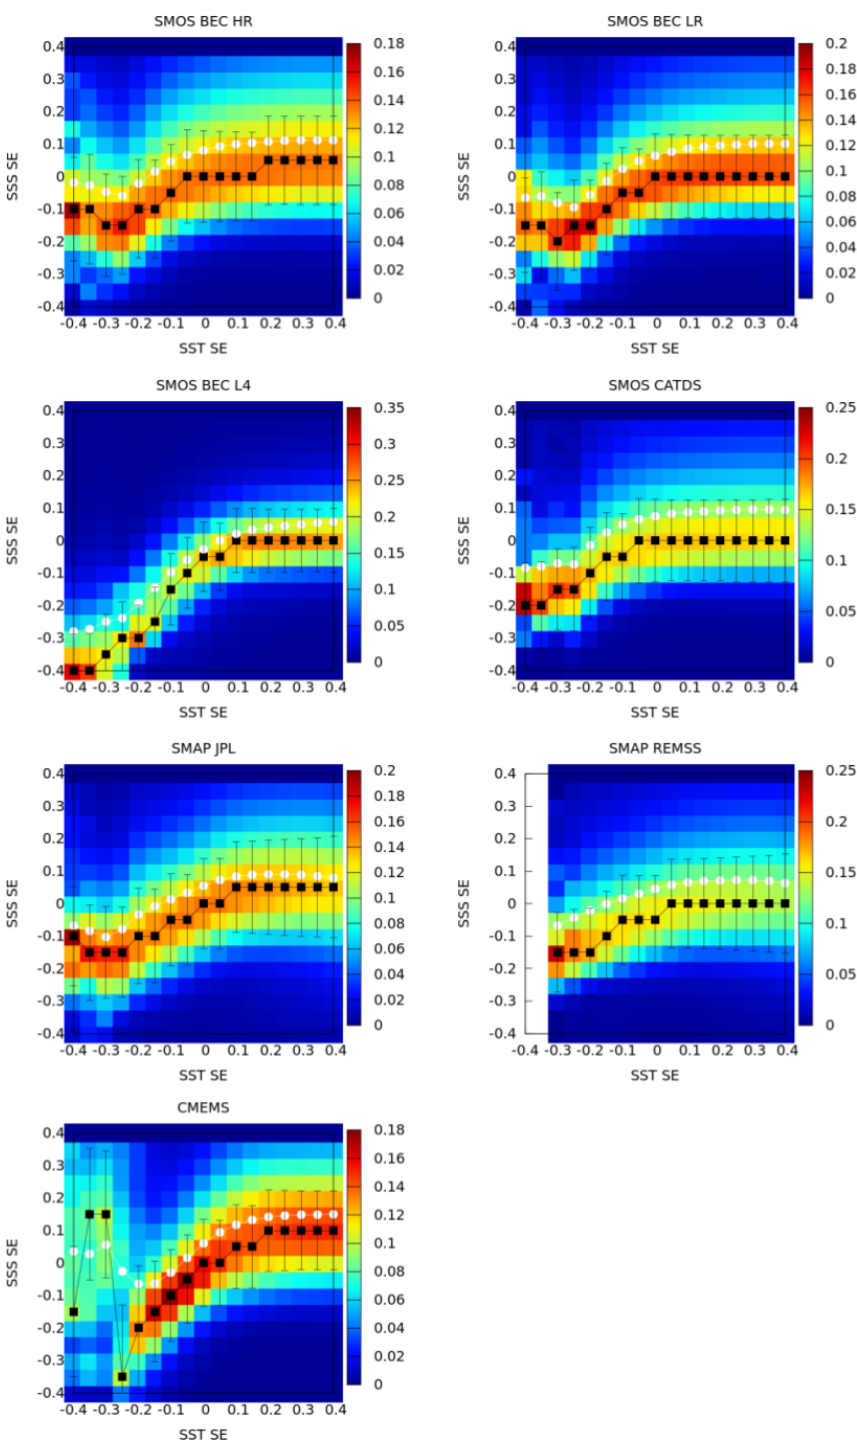
Figure 12. Histogram of SEs of SSS conditioned to the SEs of OSTIA SST. For each SST SE bin, the corresponding SSS SE distribution is normalized by the total number of SSS SEs. The black line corresponds to the mode of the SE SSS at each bin of SE SST ( H 0 in the text). The white line corresponds to the mean SE SSS at each bin of SE SST ( ¯ H in the text). In the first row from left to right, the SSS products correspond to BEC HR, BEC LR, and BEC L4. In the second row from left to right the products correspond to CATDS, JPL, and REMSS, and in the third row CMEMS products are